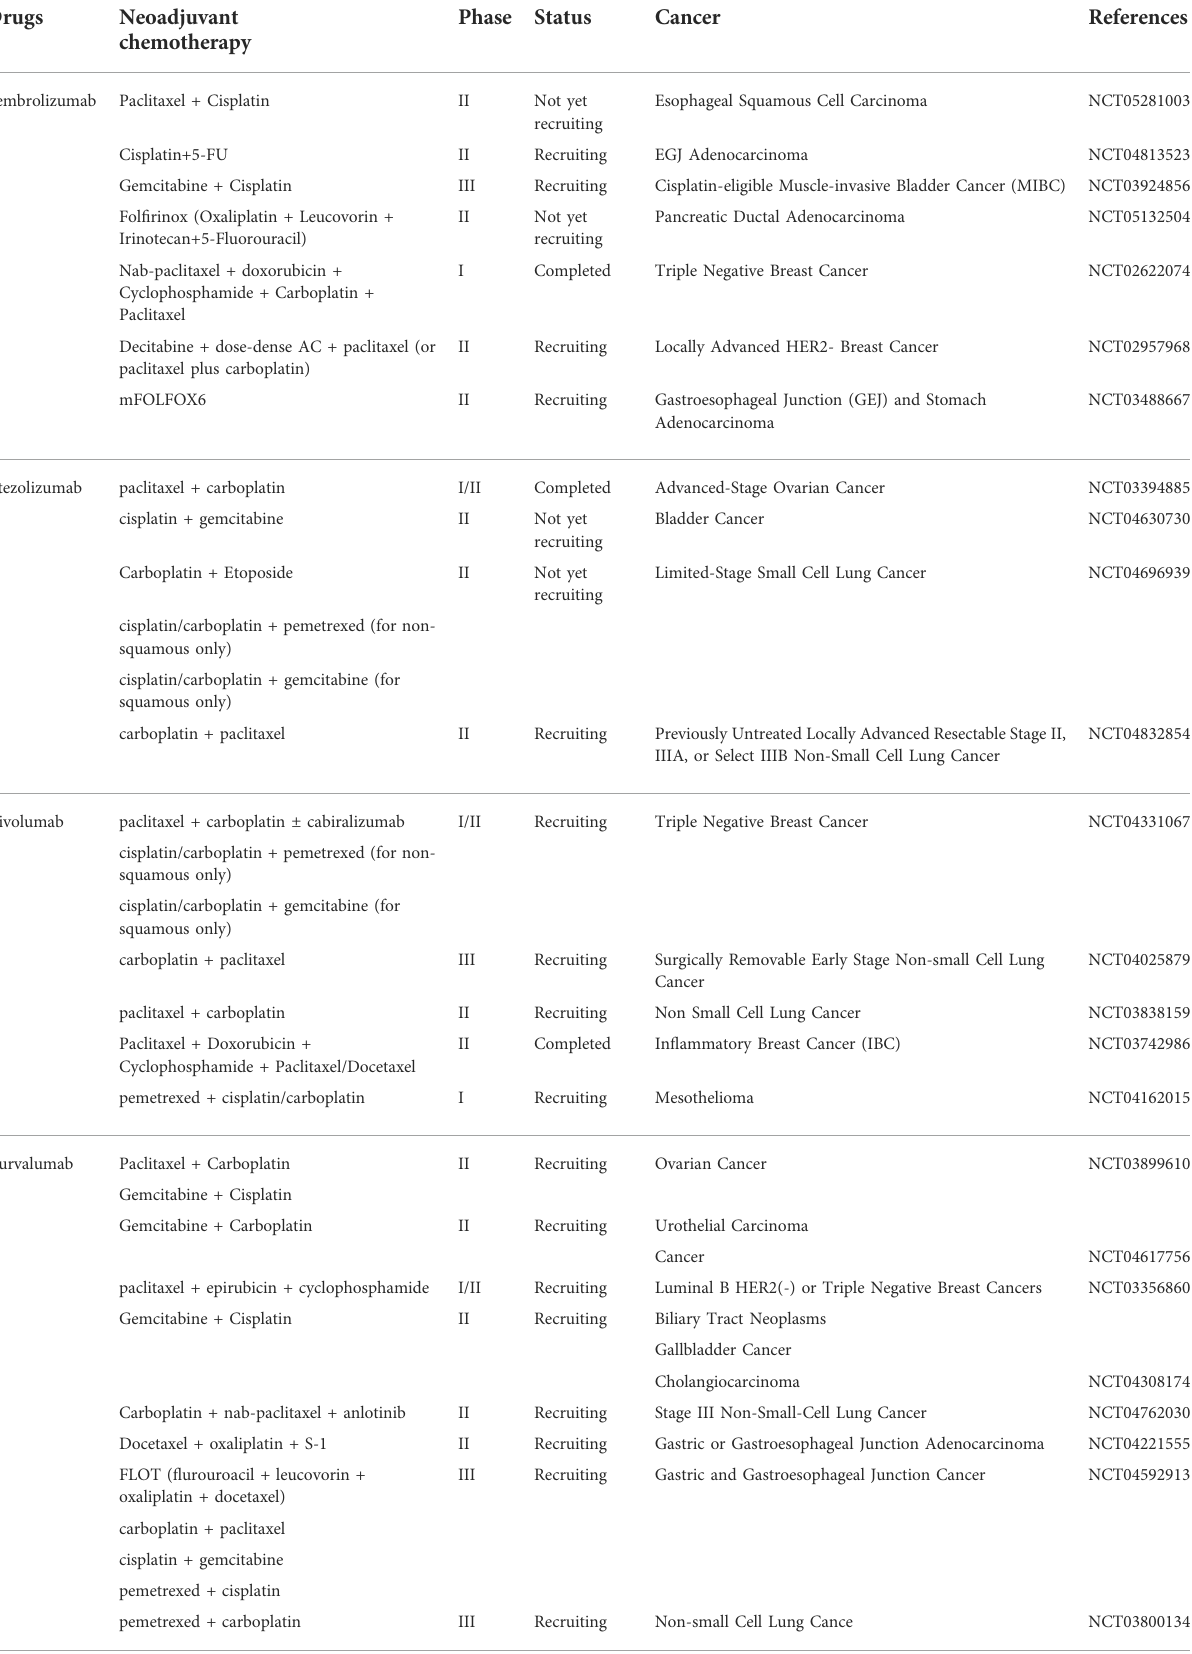
TABLE 2 Clinical trials on neoadjuvant immuno-chemotherapy in